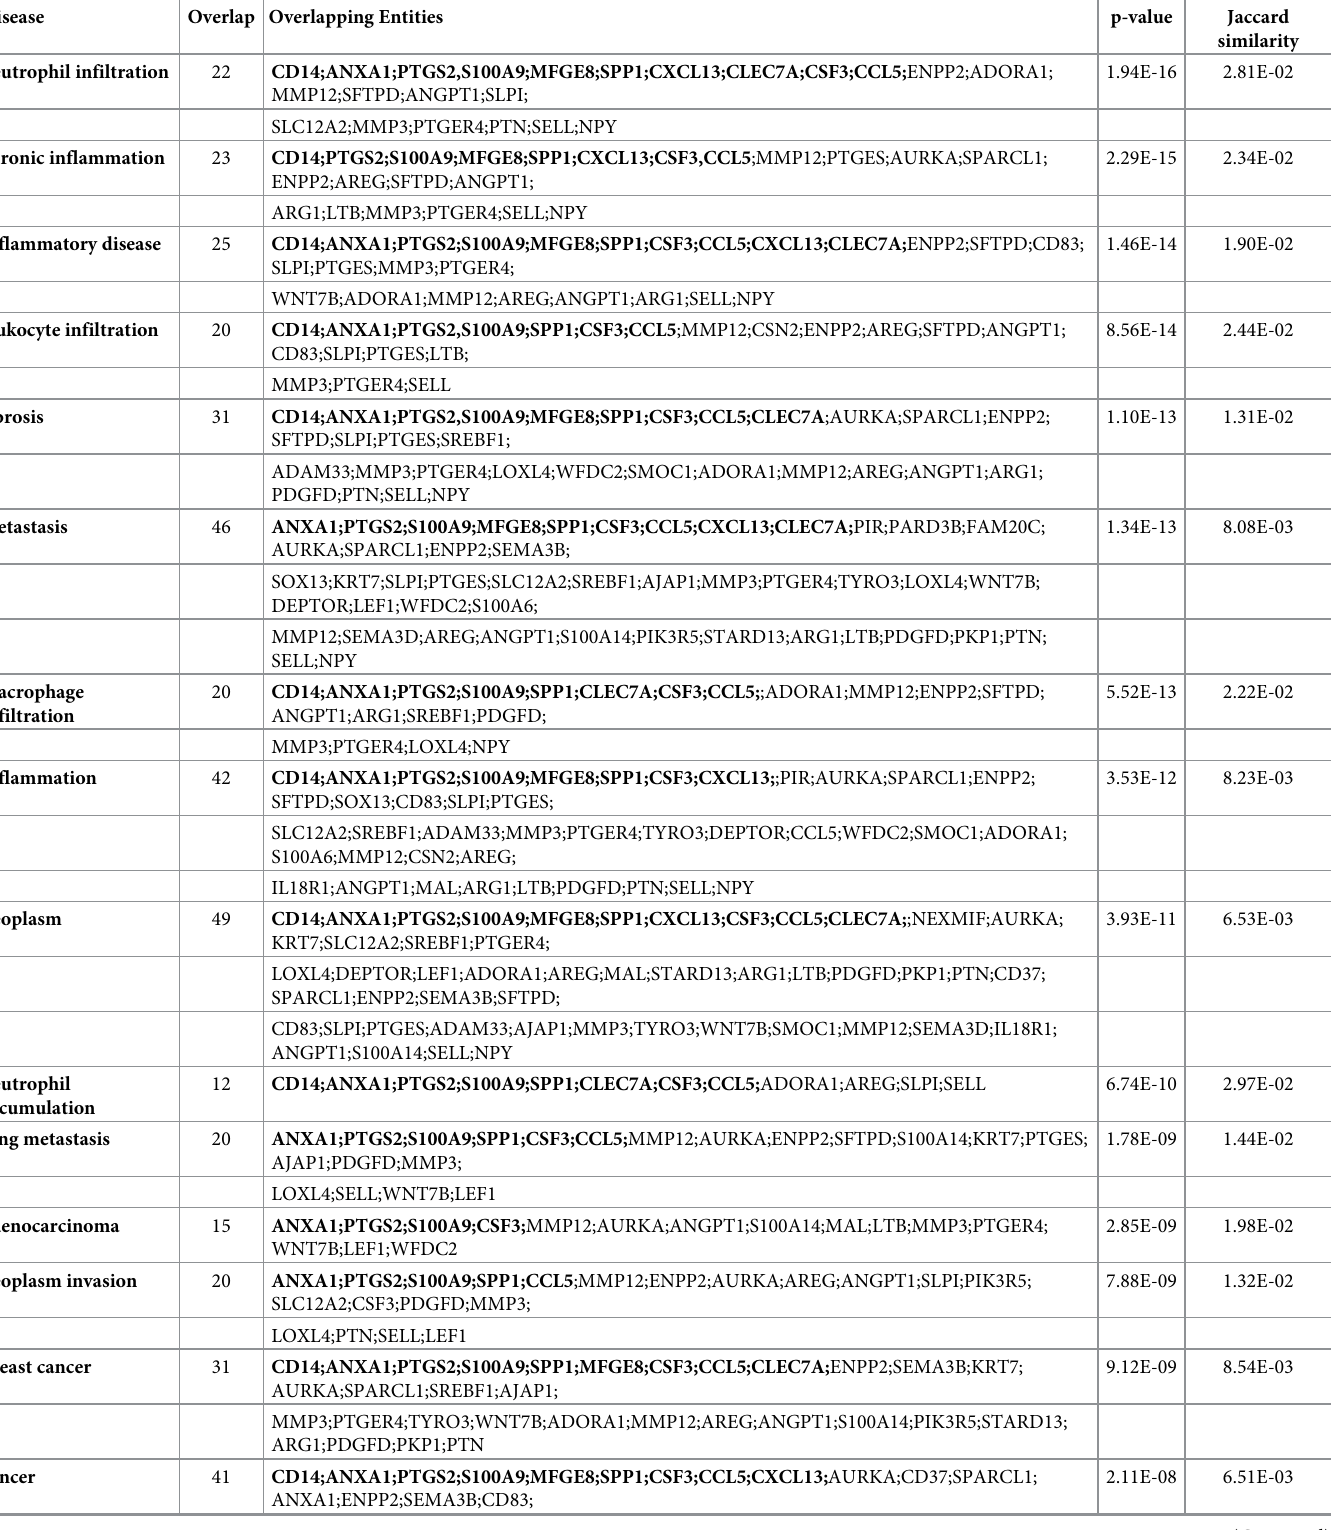
Table 1. Disease networks enriched in genes downregulated in tumors from NeuT/ATTAC+AP mice treated with DMHCA.